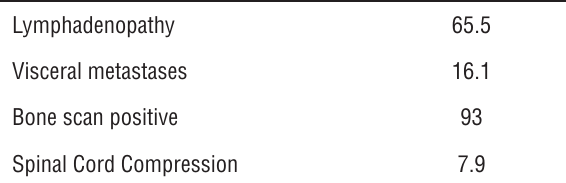
Table 2 - Findings on imaging within 30 days of diagnosis (%).